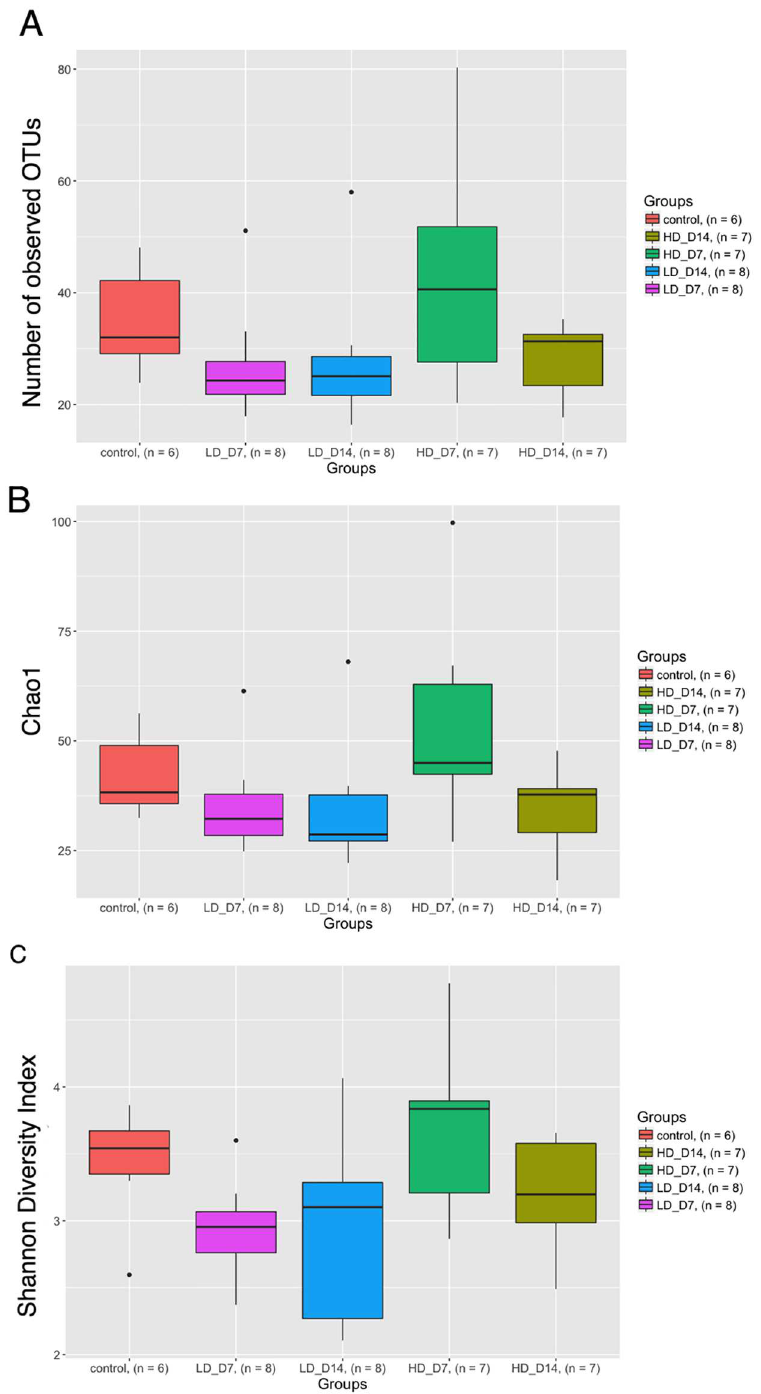
Fig 1. Changes in the alpha diversity of the Atlantic salmon skin microbial community in response to SAV3 infection. A) Total number of OTUs. B) Chao1. C) Shannon diversity index. LD_D7: low-doseinfected day 7; LD_D14:low-doseinfected day 14; HD_D7: high-dose infected day 7; HD_D14:high-dose infected day